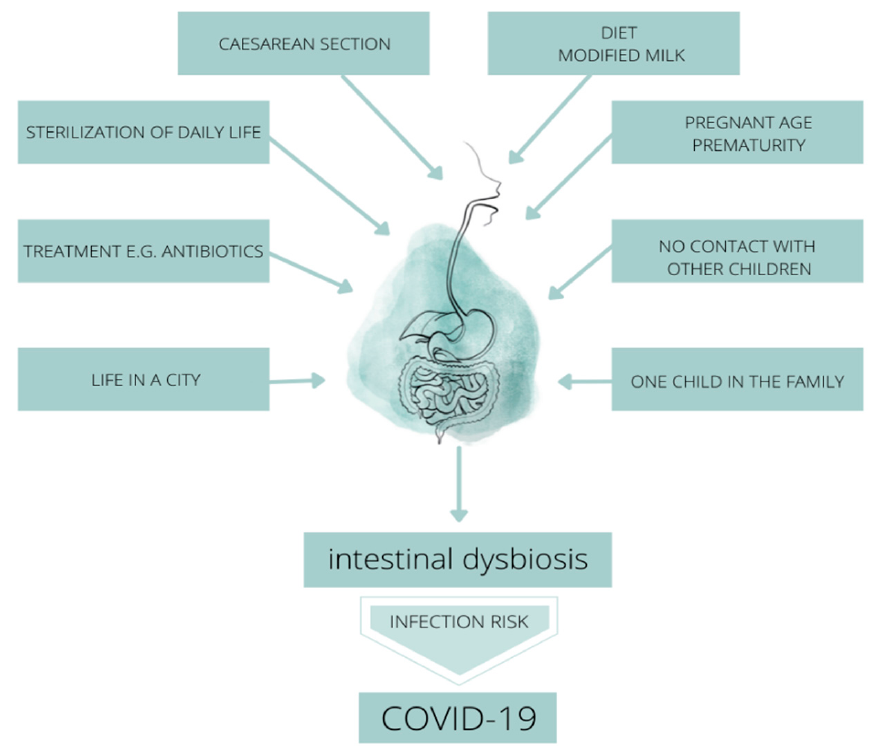
Figure 4. Factors influencing the development of intestinal dysbiosis in the period of shaping the intestinal microbiome in terms of the risk of SARS-CoV-2 infection. Factors predisposing to stimulation of the mechanism of intrauterine programming constitute response of adaptation of the environment inside the organism and activate a series of reactions leading to intrauterine balance. Because of the risk of pathological changes, pregnancy lasting more than 42 weeks may adversely affect the health of the newborn, even until adolescence. The factors affecting the mechanism of fetal programming is shown in Figure 5